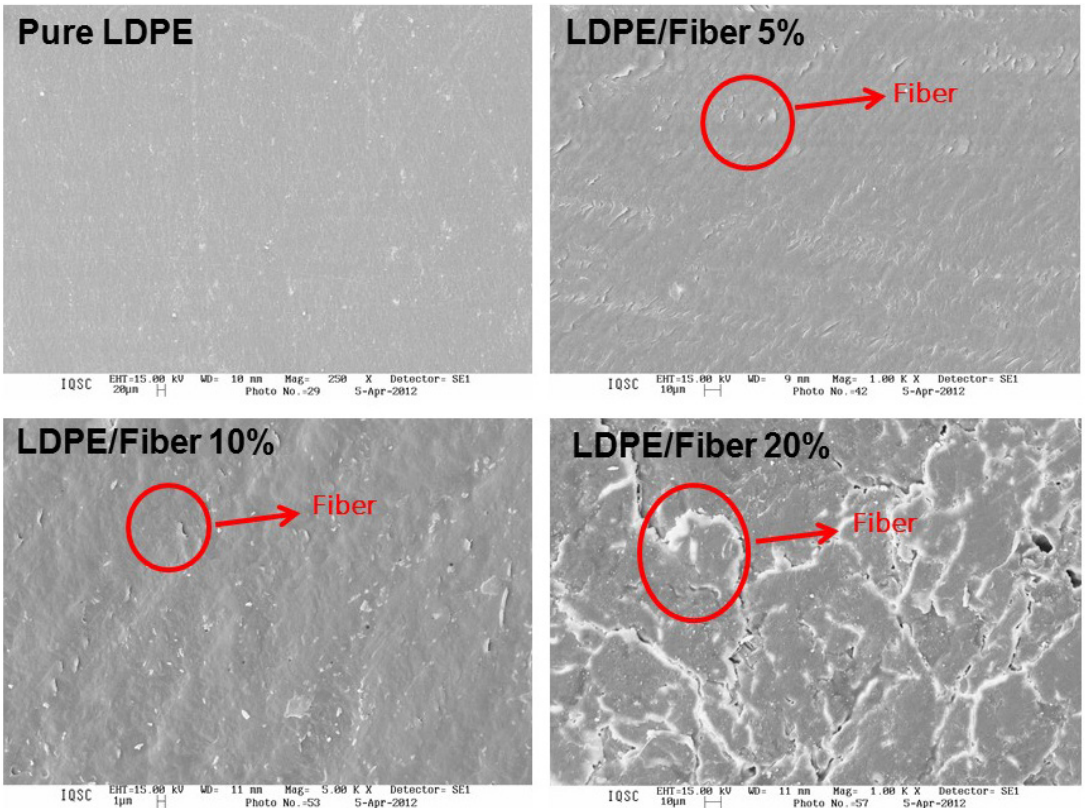
Figure 3. SEM of the pure LDPE matrix and the composites containing babassu